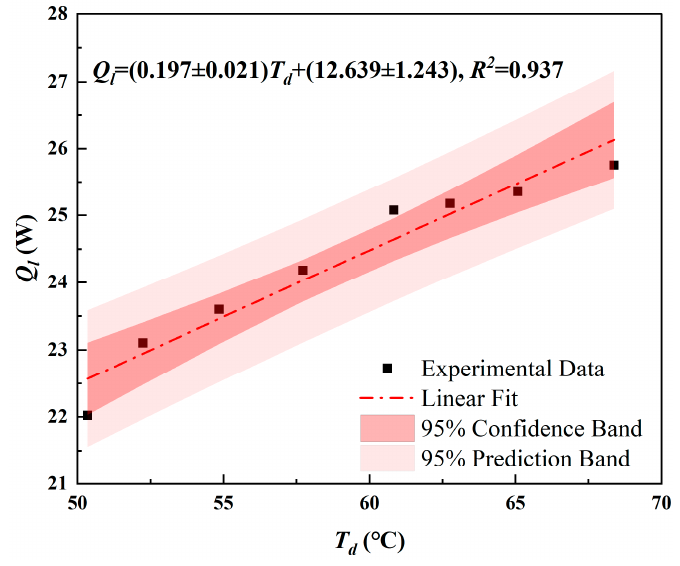
Figure 7. Prediction of heat loss for the continuous heat sink without membrane under mass flux of 80.48 kg m − 2 s − 1 .